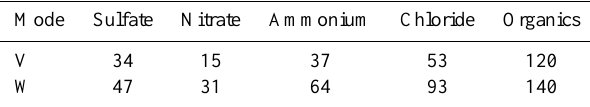
Table 1. The detection limits (ngm − 3 ) of species measured by AMS in V mode and in W